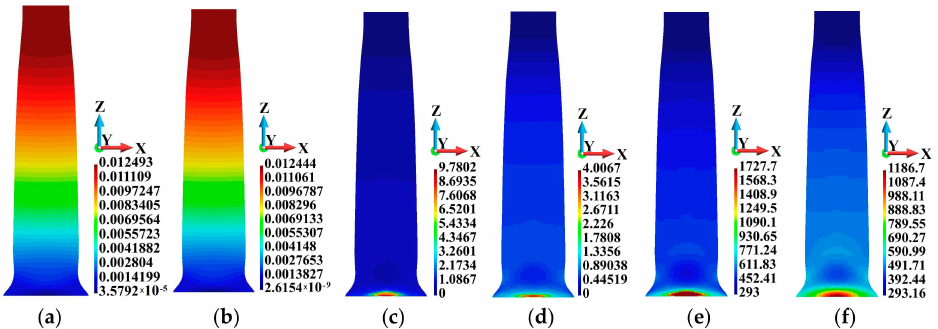
Figure 2. Comparison of the adiabatic and coupled solutions: ( a ) displacement field (m), adiabatic solution; ( b ) displacement field (m), coupled solution; ( c ) equivalent plastic strain field (non-dimensional), adiabatic solution; ( d ) equivalent plastic strain field (non-dimensional), coupled solution; ( e ) temperature field (K), adiabatic solution; ( f ) temperature field (K), coupled solution.